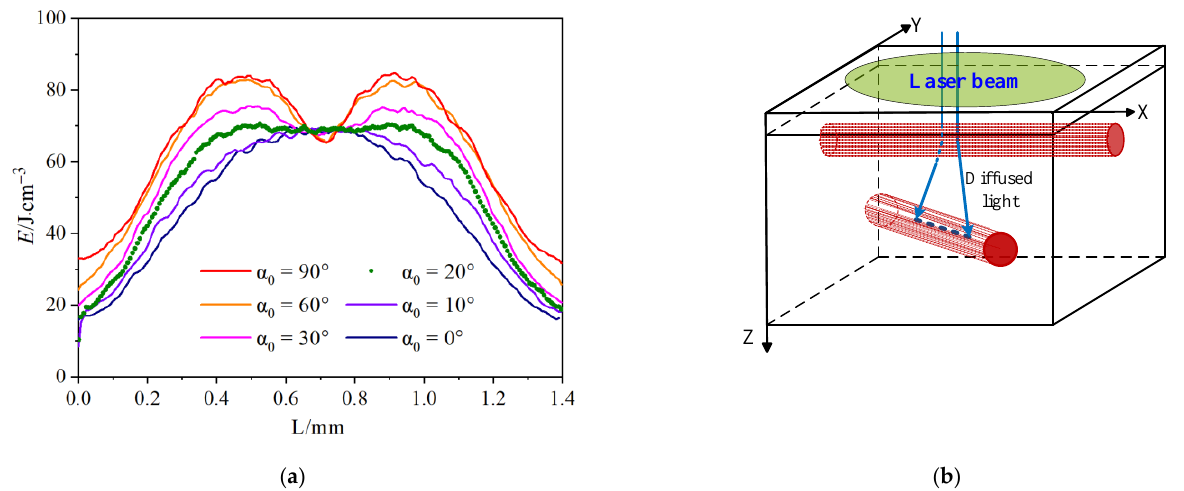
Figure 13. Effect of cross angle ( α 0 ) on energy deposition in the axis of the deep blood vessel at D = 120 μm and H cshad = 250 μm. ( a ) Energy deposition along the vessel axis. ( b ) Diagram of energy deposition in the deep vessel at α 0 > 20° and H cshad = 250 μm.